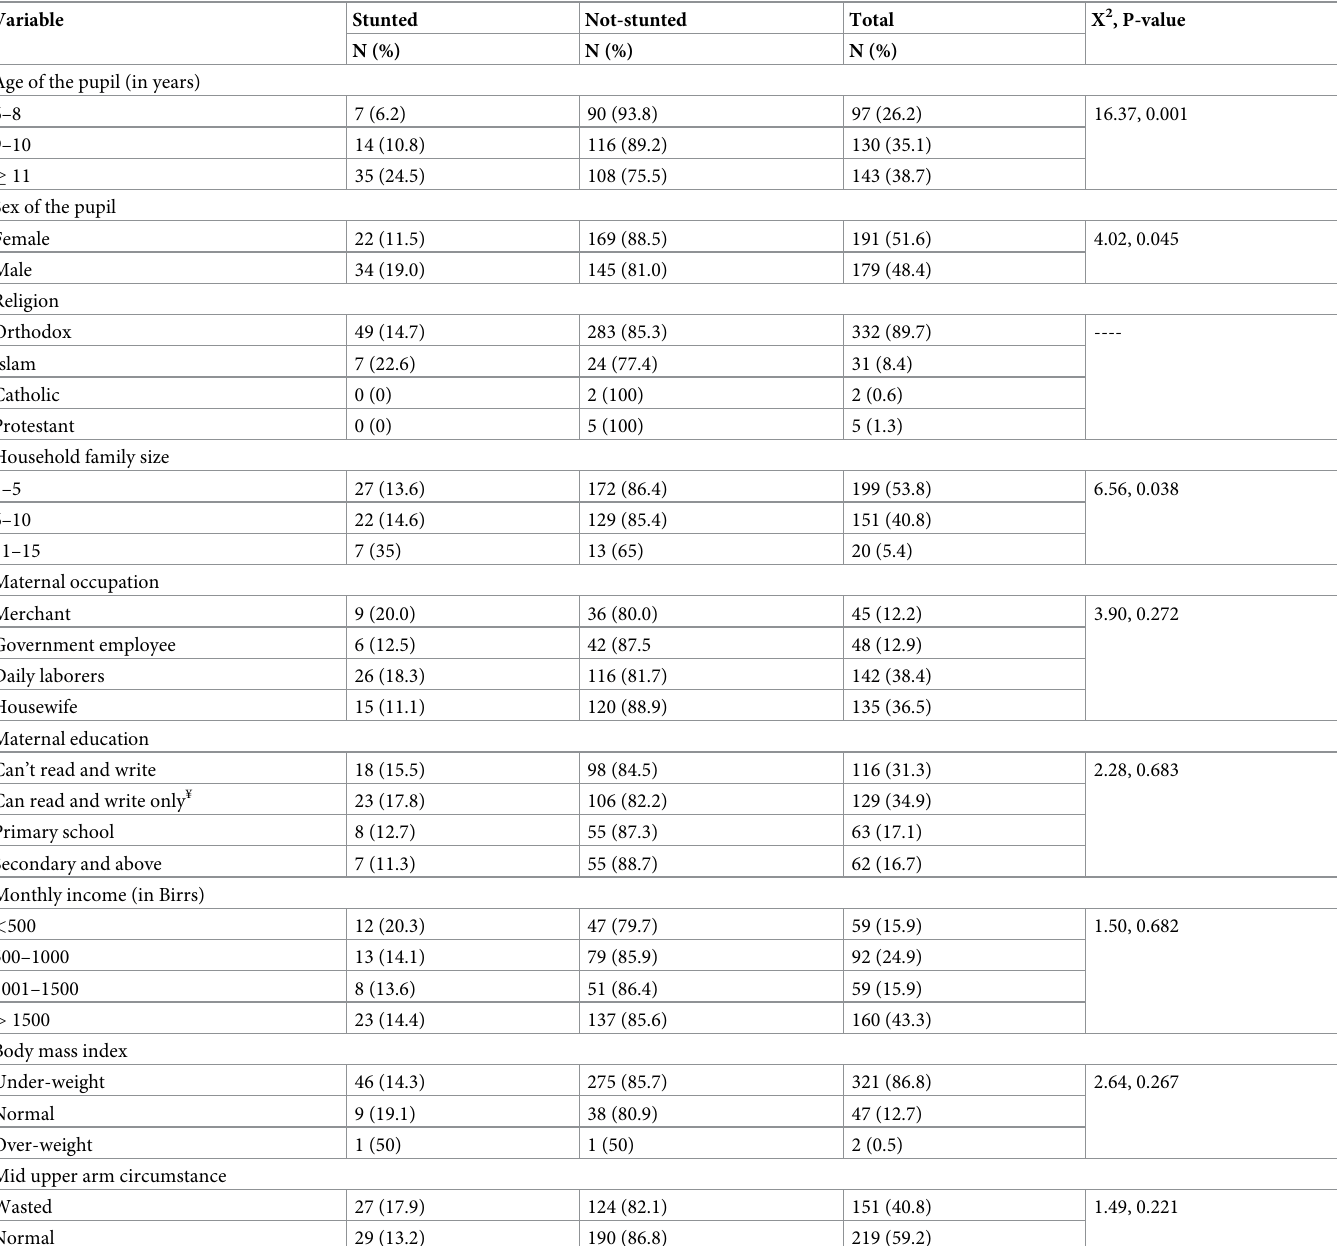
Table 1. The relationship of socio-demographic characteristics and stunting among Bahir Dar city public primary school pupils, North West Ethiopia, 2019. Variable